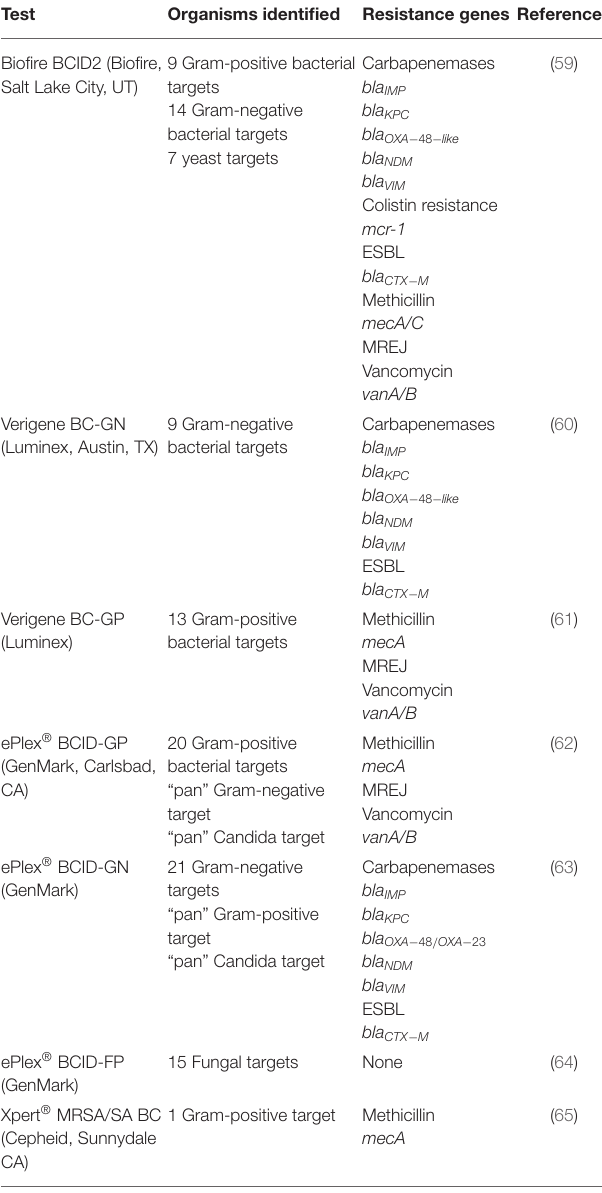
TABLE 2 | Select genotypic tests that are approved for rapid detection of resistance markers in positive blood cultures. Test Organisms identified Resistance genes